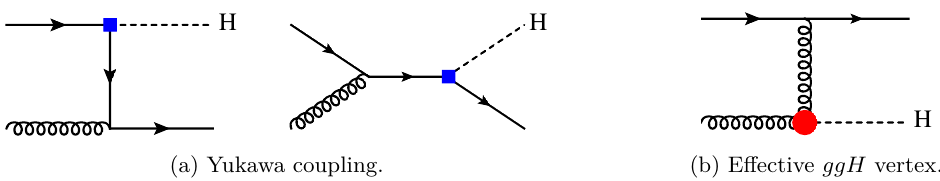
Figure 1 . Leading-order Feynman diagrams contributing to the pp → Hc process. We distinguish two separate production mechanisms: one that is driven by the Yukawa coupling (left) and the other one that requires direct coupling of Higgs to gluons